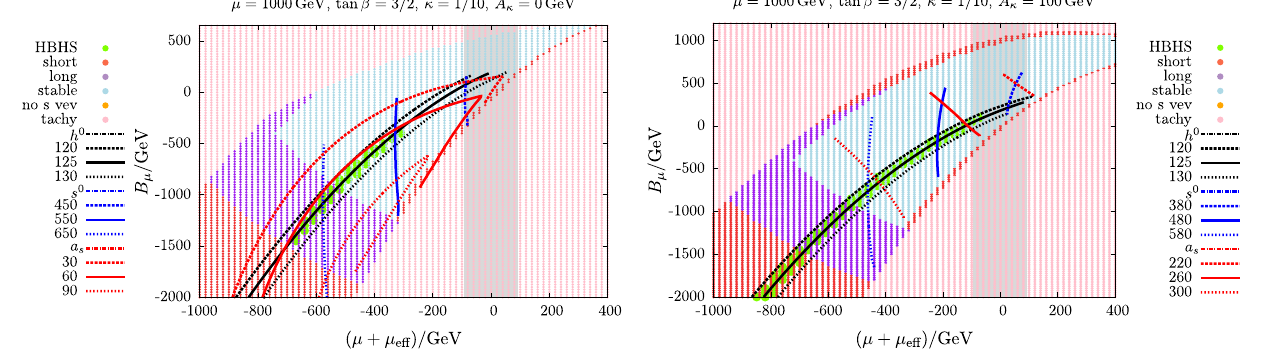
by the gray-shaded band: Ref. [152] reports a lower